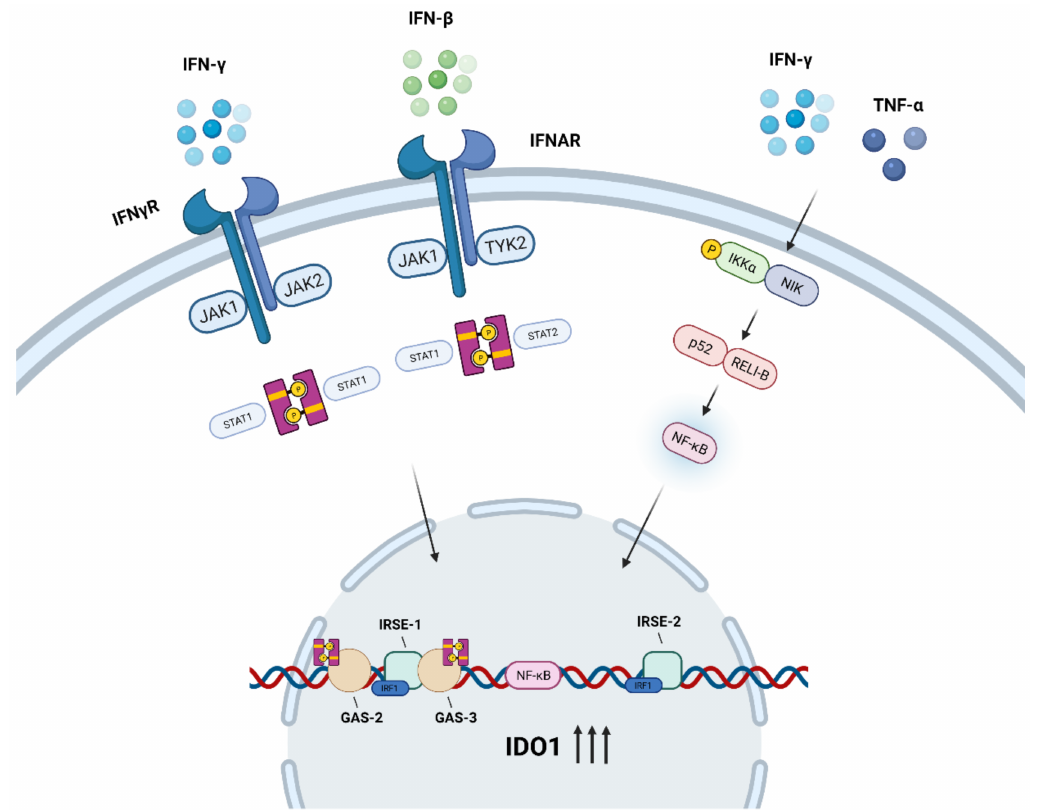
Figure 1. Regulation of activating IDO1 transcription. IFN- γ promotes STAT1 phosphorylation by JAK, then STAT1 dimerization binding to GAS-2 and GAS-3 sites upstream of the IDO1 coding region to activate IDO1 transcription and induce IRF-1 synthesis. IRF-1 binds to ISRE-1 and ISRE-2 sites in concert with STAT1 to promote IDO expression. IFN- β upregulates IDO1 expression via activating JAK1/TyK2 and STAT1/STAT2. Another regulatory pathway, activation of IKK α by NF- κ B-inducing kinase (NIK) results in the formation of p52-REL-B dimers, which promotes NF- κ B translocation and attaches to the IDO1 coding region. TNF- α synergistically enhancing the IDO1 induction effect of IFN- γ